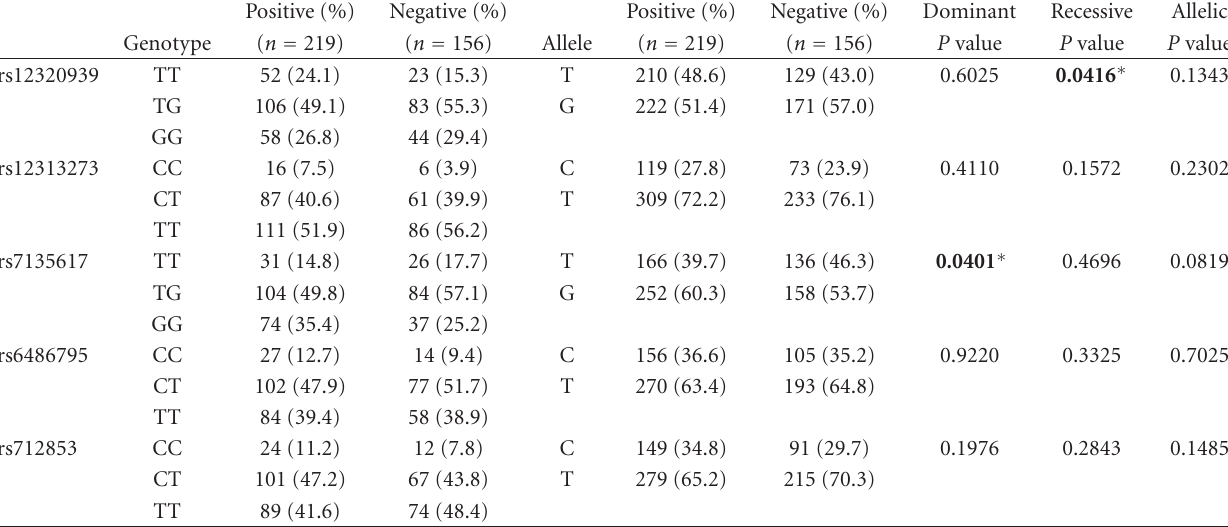
Table 3: Genotyping and allele frequency of ORAI1 gene in patients with breast cancer with di ff erent progesterone receptor (PR) status.